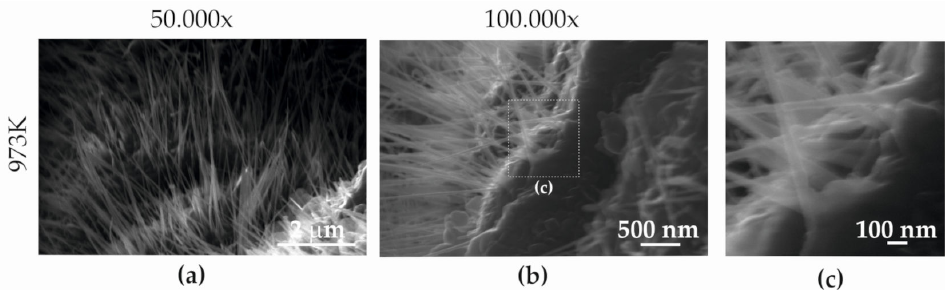
Figure 15. Thread surface microfractography of Armstal 550 steel specimens after tests conducted at temperatures of ( a ) 773 K and ( b , c ) 973 K.